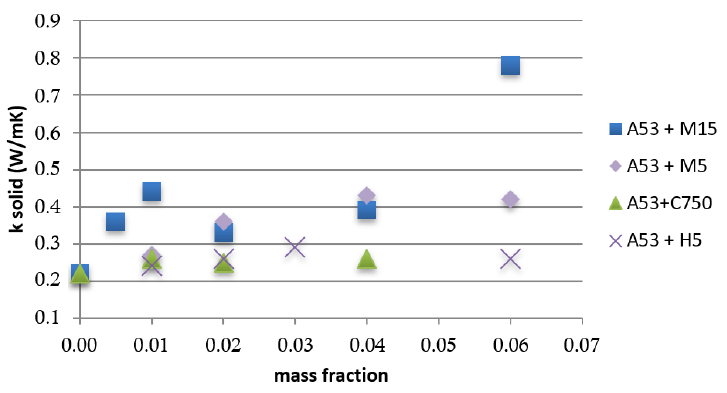
Figure 3. Thermal conductivity of paraffin wax with graphite nanoplatelets as a function of mass fraction with different sizes, aspect ratios, and surface areas: squares, M15 (d = 15 μ m, thickness = 6 – 8 nm, and surface area = 120 – 150 m 2 /g); rhombus, Μ 5 ( d = 5 μ m, thickness = 6 – 8 nm, and surface area = 120 – 150 m 2 /g); crosses, H5 ( d = 5 μ m, thickness = 15 nm, and surface area = 50 – 80 m 2 /g); and triangle, C750 (d < 2 μ m, thickness = a few nm, and surface area = 750 m 2 /g).